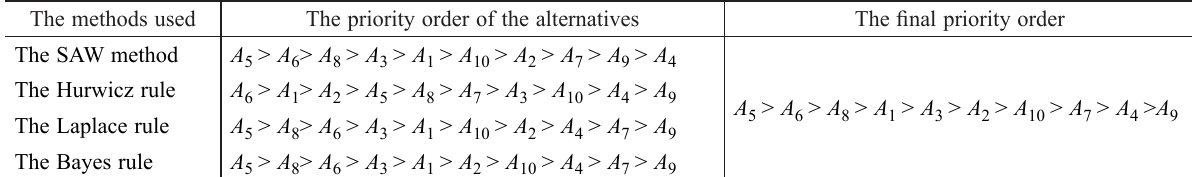
Table 6. The summary table of the data obtained in the analysis performed by all methods The methods